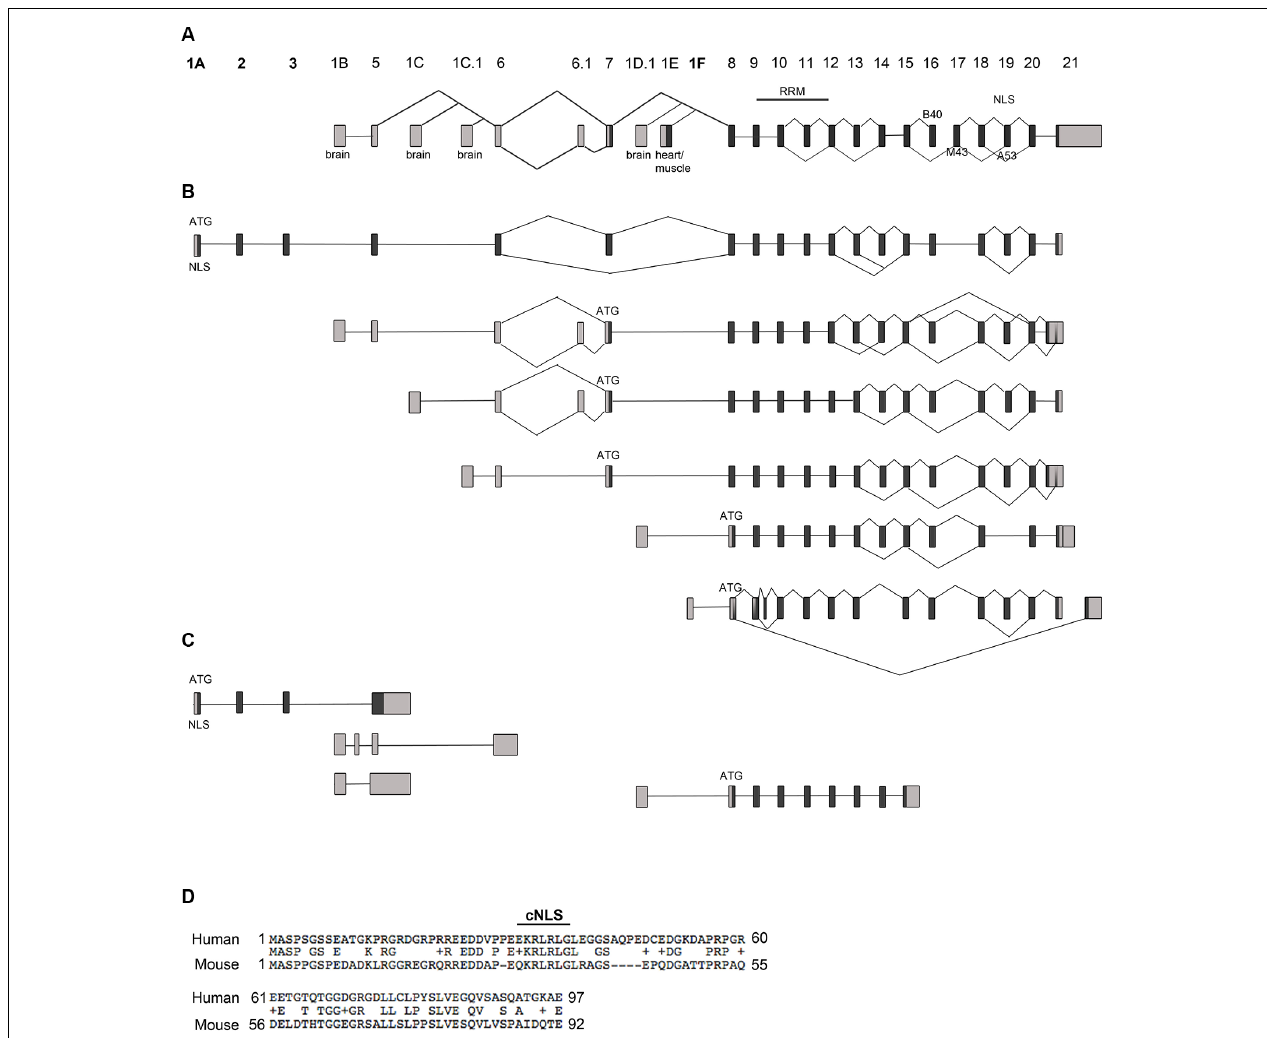
FIGURE 1 | Rbfox1 transcript identification in the cerebral cortex. (A) Scheme of the Rbfox1 gene with the known exon annotation (Damianov and Black, 2010). (B,C) A summary of the alternative Rbfox1 transcripts expressed in the perinatal cerebral cortex. Total RNA was isolated from P0 mouse cortices and used for Iso-Seq. (B) Full-length Rbfox1 transcripts. (C) Three prime truncated Rbfox1 transcripts. Boxes represent exons. Dark gray boxes indicate coding exons and light gray boxes non-coding exons. Novel exons are named 1A, 2, 3, and 1F. Alternative exons B40, M43, and A53 are shown. RRM, RNA recognition motif;